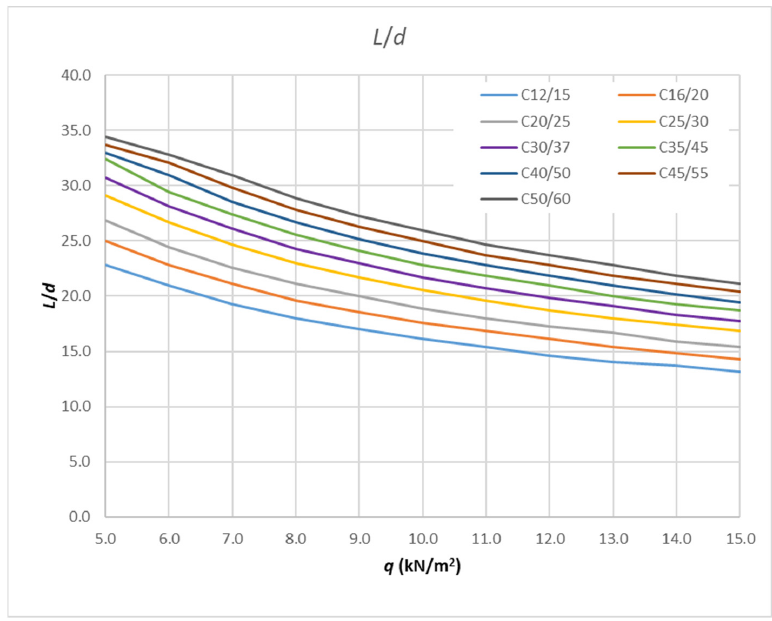
Figure 13. Slenderness envelope curves for each concrete class (lower bound values). Table 10. Slenderness limit envelope